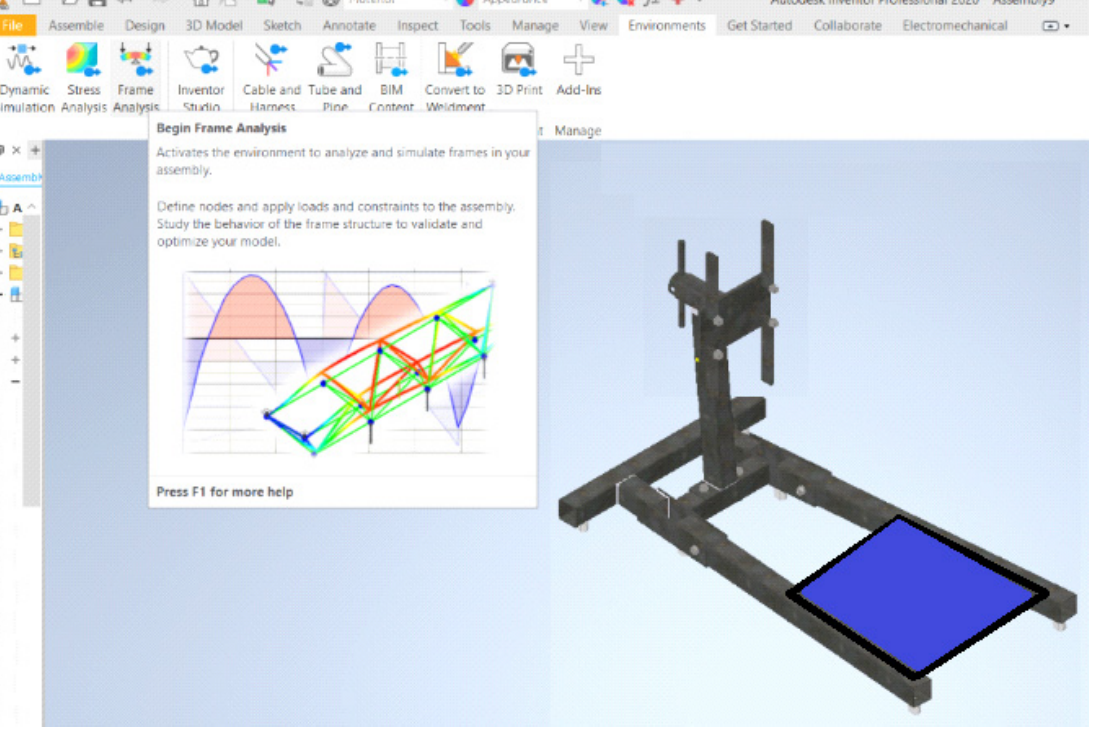
Figure 9. Mechanical structure of the arm developed in CAD stage to begin stress frame analysis.